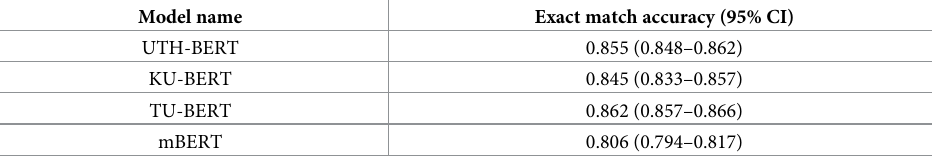
Table 4. The exact-match accuracy of each model with five-fold cross validation.